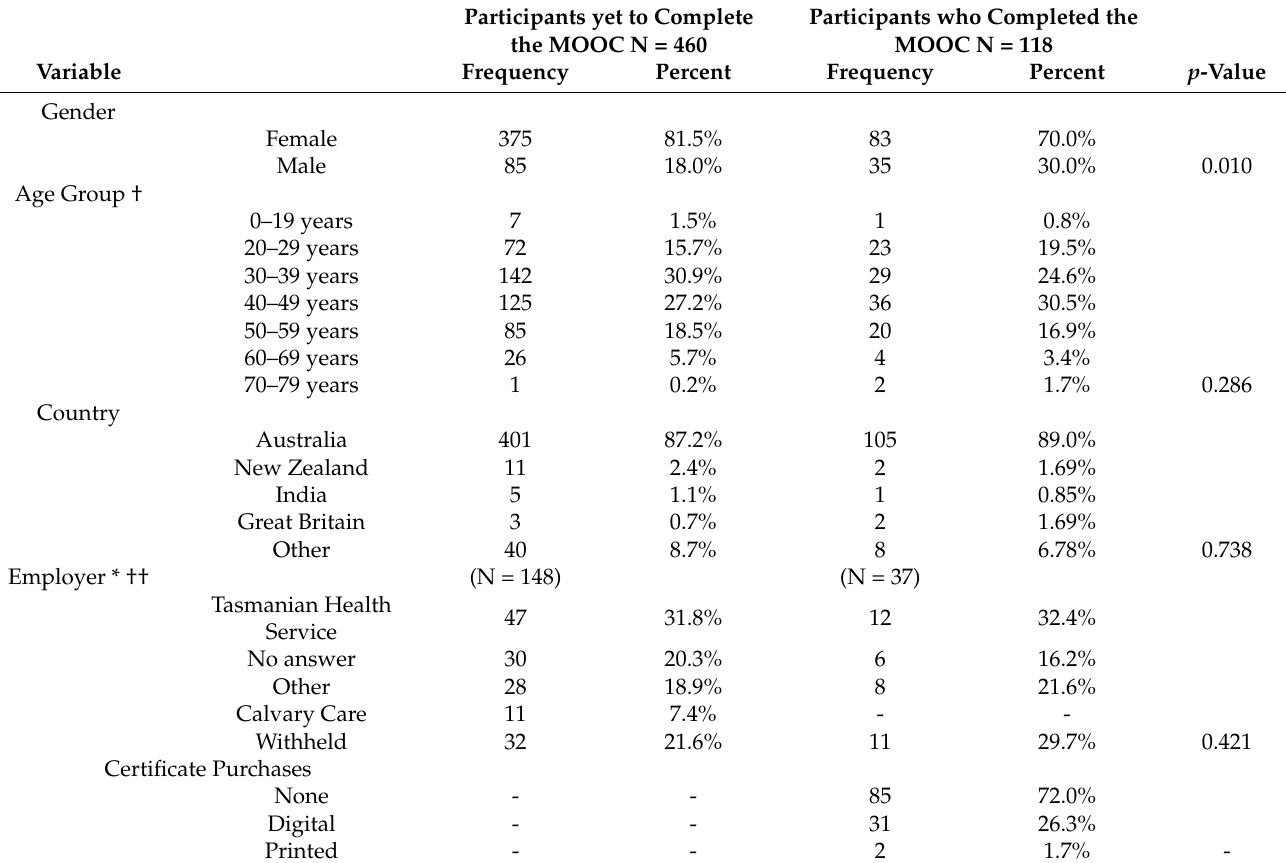
Table 2. Participant